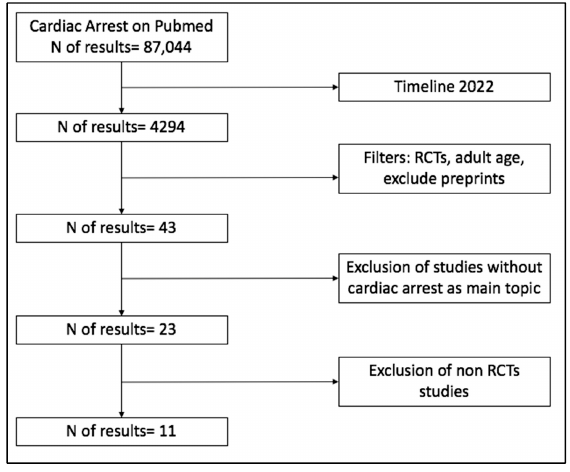
Figure 2. Diagram flow of article selection for inclusion in the review.